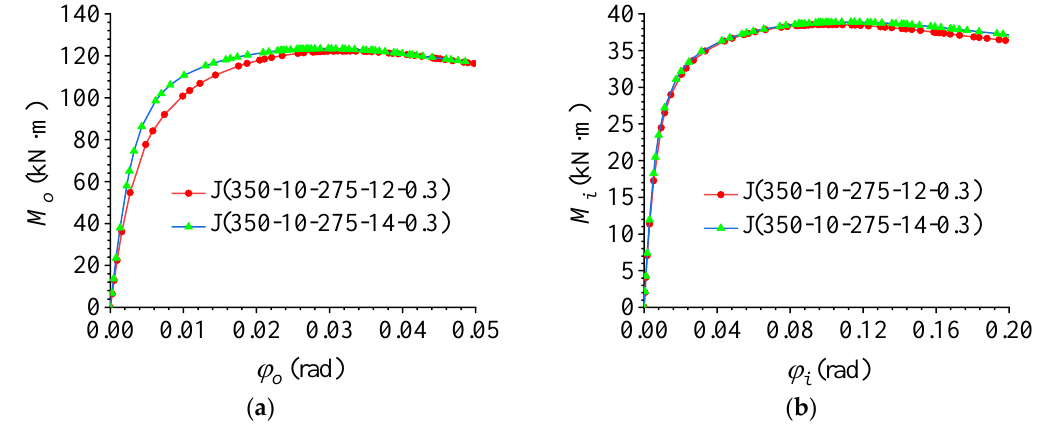
Figure 18. Effect of joint plate thickness. ( a ) Out-of-plane M–φ curve; ( b ) in-plane M–φ curve.